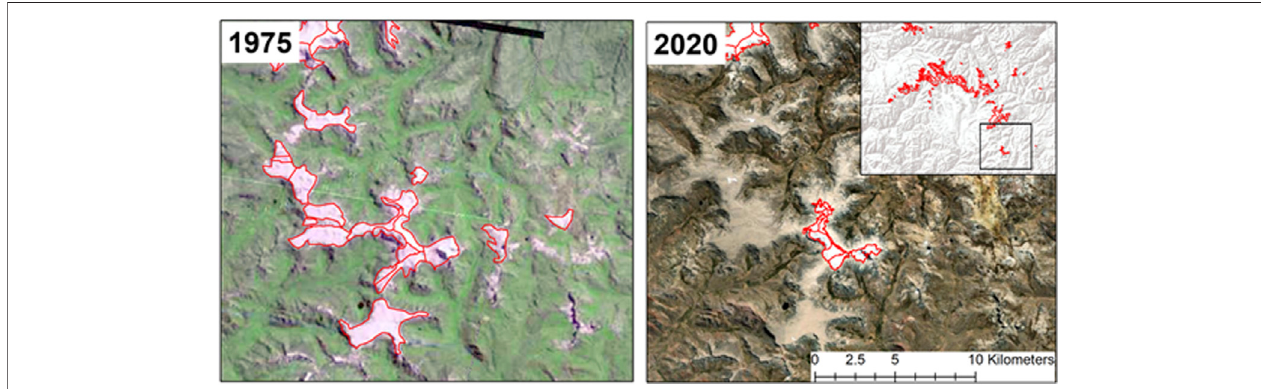
FIGURE8| AsmallclusterofglaciersintheCordilleraVilcanotatothesouth-eastoftheQuelccayaicecapalmostcompletelymeltinginthe45-yeartimespanofthis series. 1975 background image is from Landsat-2, 2020 image is from DigitalGlobe.